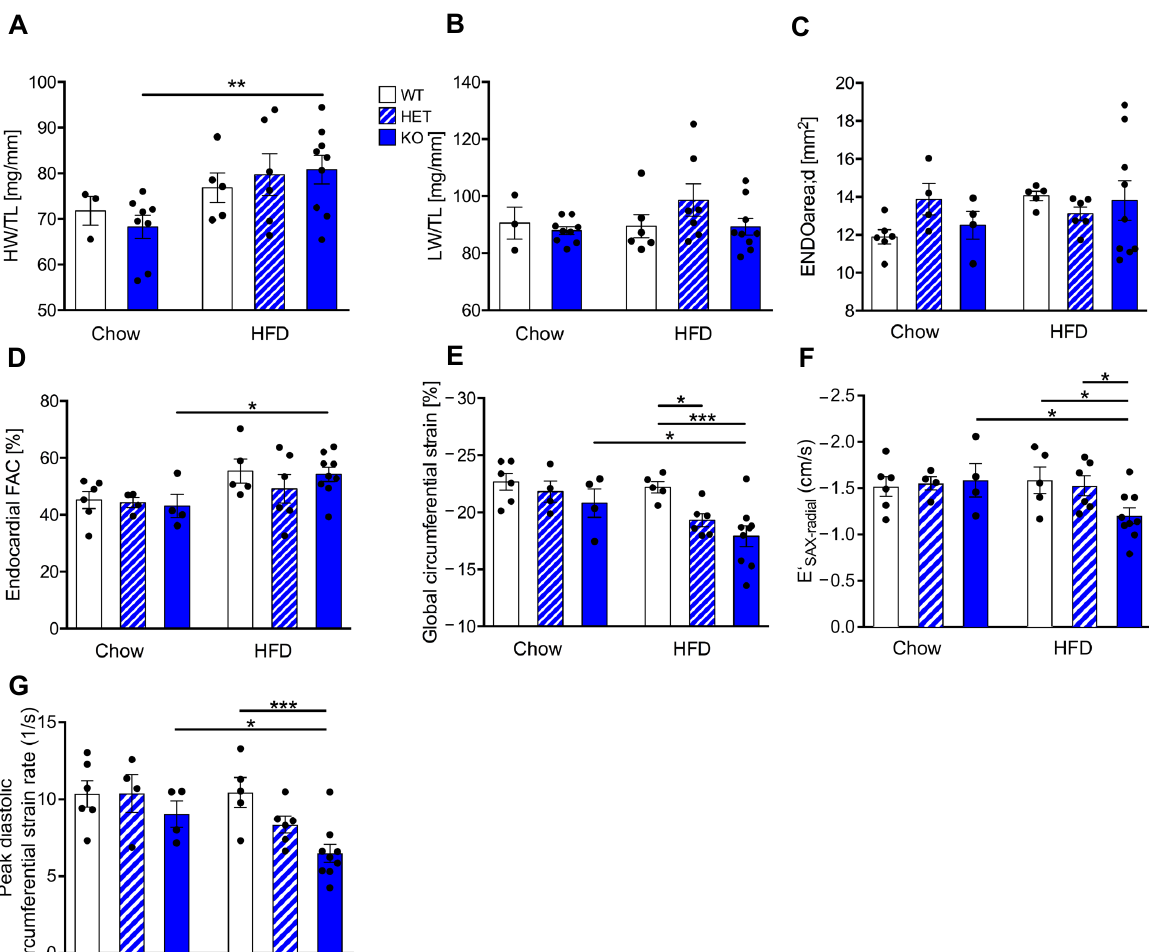
Figure 2. CTRP9 knock-out leads to increased heart weight and impaired cardiac diastolic function during high-fat diet (HFD). ( A ) Ratio between heart weight (HW) and tibia length (TL). WT: wild-type mice; KO homozygous and HET heterozygous CTRP9 knock-out mice. ( B ) Ratio between lung weight (LW) and TL. ( C , D ) Echocardiographic analysis. ( C ) Enddiastolic area. ( D ) Endocardial fractional area change (FAC). ( E ) Global circumferential strain as marker of global cardiac function. ( F ) E (cid:48) SAX-radial indicates average endocardial movement during cardiac relaxation. ( G ) Peak diastolic circumferential strain rate as a marker of lusitropy. Data are shown as mean ± standard error of the mean (SEM). * p < 0.05, ** p < 0.01, *** p < 0.001.